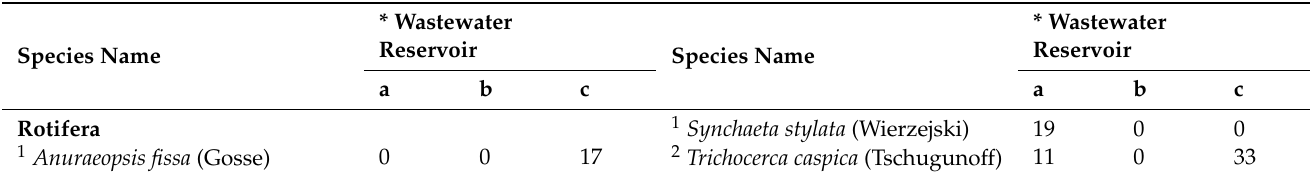
Table 3. Frequency of occurrence (%) of planktonic invertebrates in wastewater reservoirs of the Right-Bank Sorbulak Canal system, 2021.